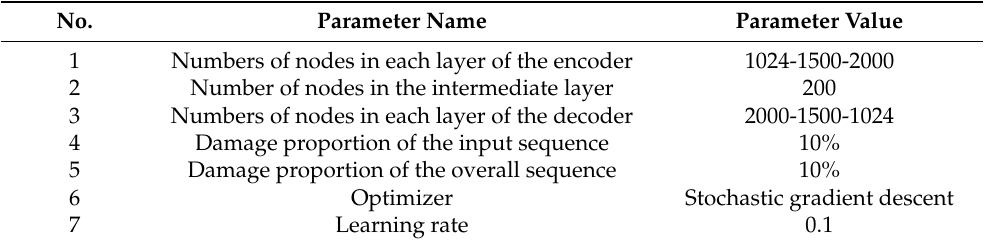
Table 2. Structural parameters of the VSADE for the frequency-domain